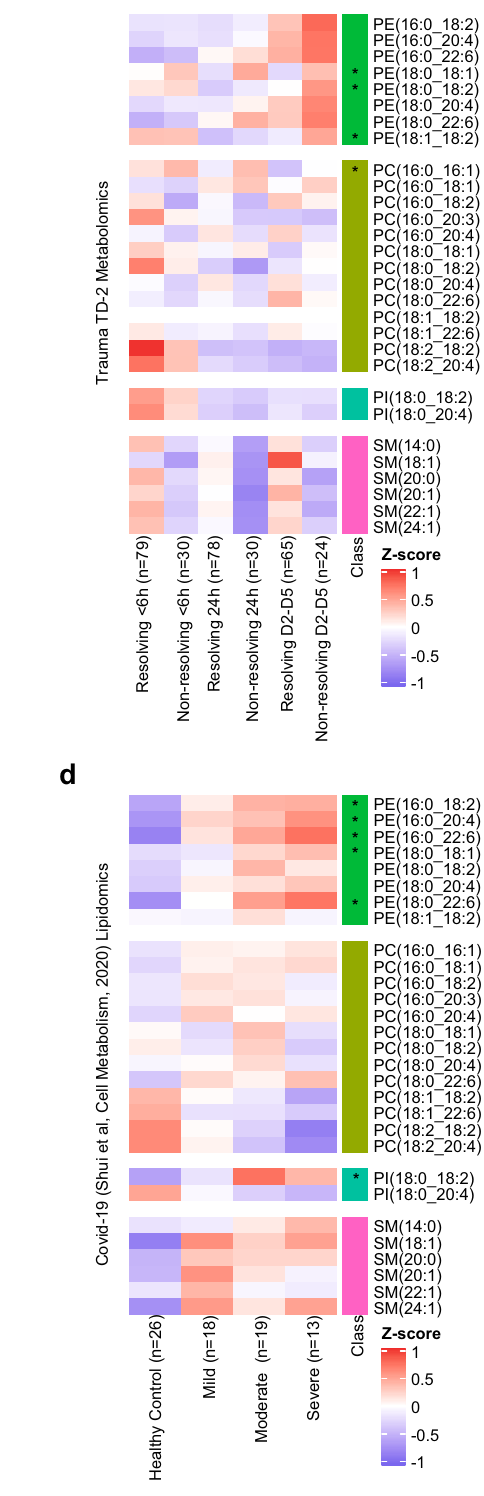
lipidswithstatisticalsigni fi cance( p value<0.05)andlog2foldchange>0.4bytwo- sided Wilcoxon Rank Sum test between non-resolving and resolving trauma patients at 72h ( a ); non-resolving and resolving trauma patients at D2-D5 ( b ); severe and non-severeCovid-19patients ( c );severeand mild Covid-19 patients ( d ). Abbreviations: PE phosphatidylethanolamines, PC phosphatidylcholines, PI phos- phatidylinositols, SM